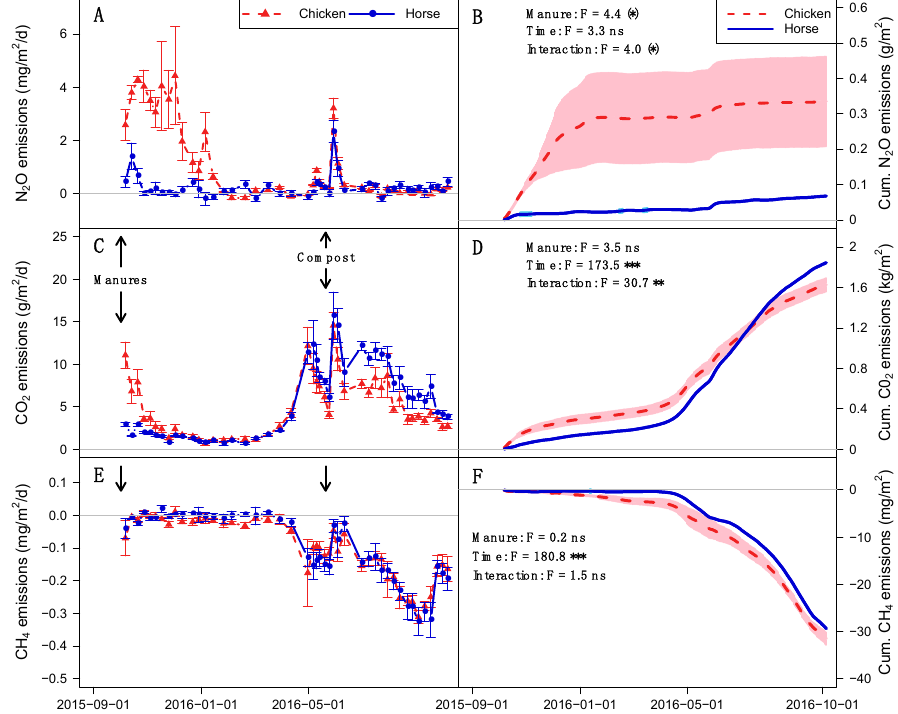
Figure 3. Temporal and cumulative fluxes (mean ± standard error) of nitrous oxide ( A , B ; N 2 O), carbon dioxide ( C , D ; CO 2 ), and methane ( E , F ; CH 4 ). Arrows indicate the date of manure (2 Oct 2015) and municipal compost (25 May 2016) application. Results from ANOVA factors refer to the full model with repeated measures, where *** = p < 0.001, ** = p < 0.01, (*) = p < 0.1, ns = p > 0.1. Chicken